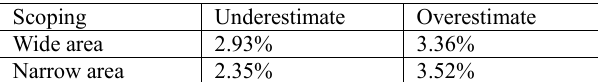
Table 2. Comparison of underestimate/overestimate areas between proposed method and manual